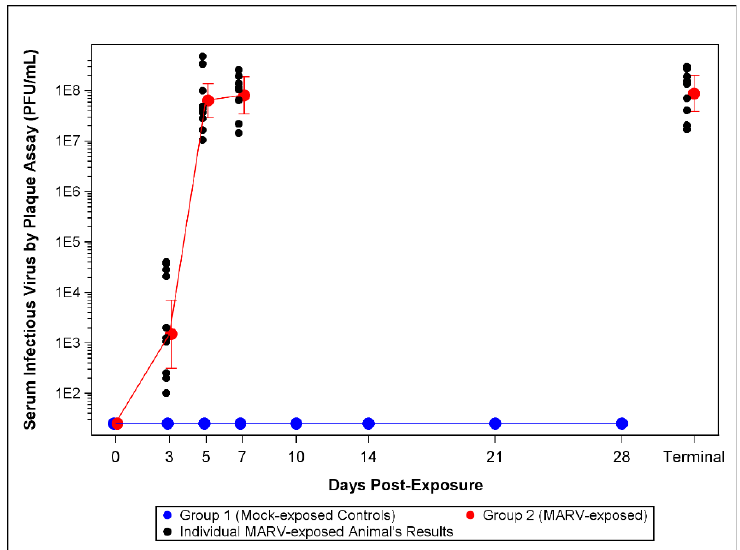
Figure 4. Plaque Assay Viremia Titers. The LLOD for the assay is 50 PFU/mL. For statistical analysis and graphing LLOD samples were assigned 25 PFU/mL. The symbols represent geometric mean concentrations and bars indicate 95% confidence intervals. The confidence intervals on Days 0 through 28 for mock-exposed control animals, and on Day 0 for MARV-exposed animals were not plotted as the results were constant and all below LLOD of 50